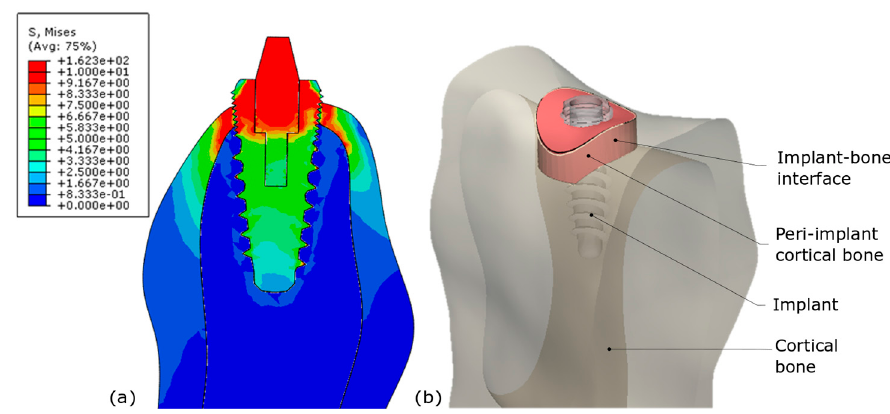
Figure 2. ( a ) Example of Von Mises stress distribution in the vestibulo-lingual plane and ( b ) representation of the cortical bone peri-implant area (unrepresented mesh).